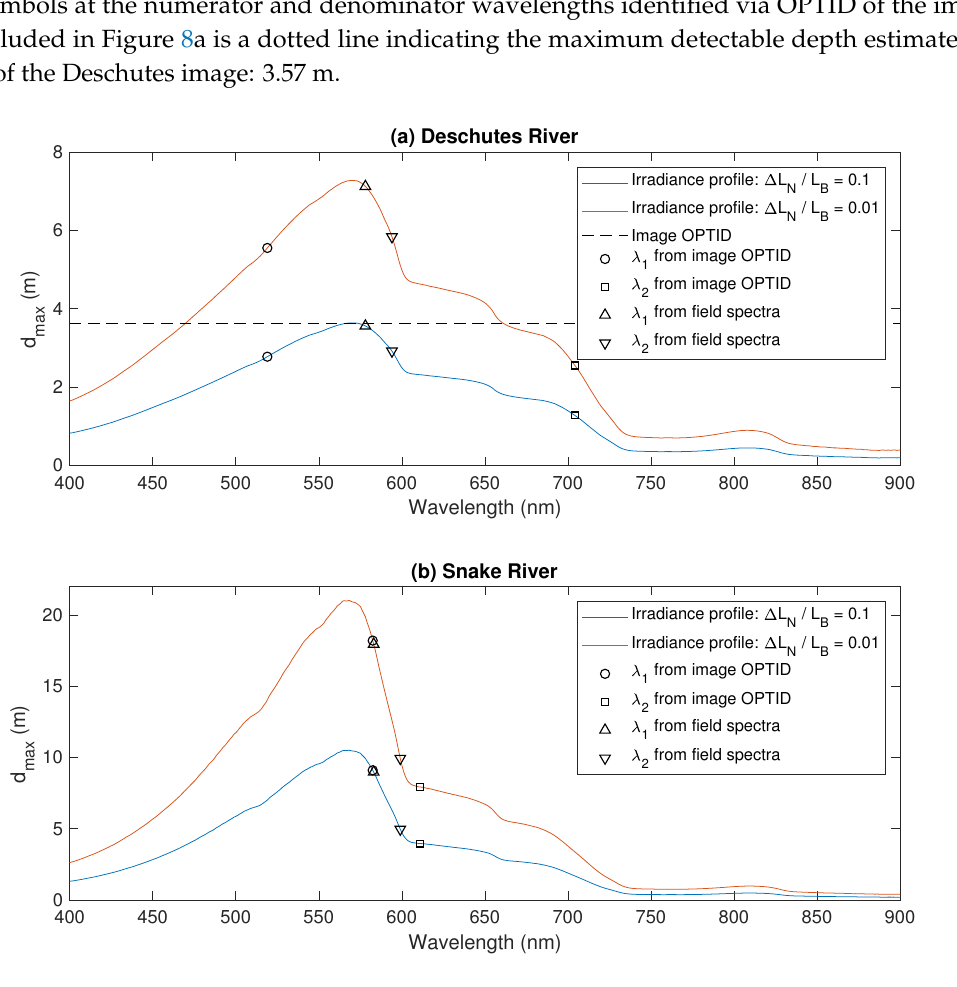
Figure 8. Maximum detectable depths calculated from measured irradiance profiles for two different values of ∆ L N / L B for the ( a ) Deschutes and ( b ) Snake Rivers. Also plotted for each site are d max values based on the irradiance profiles for the numerator ( λ 1 ) and denominator ( λ 2 ) wavelengths identified via OPTID of hyperspectral images and field spectra. For comparison, the d max inferred from OPTID of the Deschutes River image is represented by the dashed line in ( a